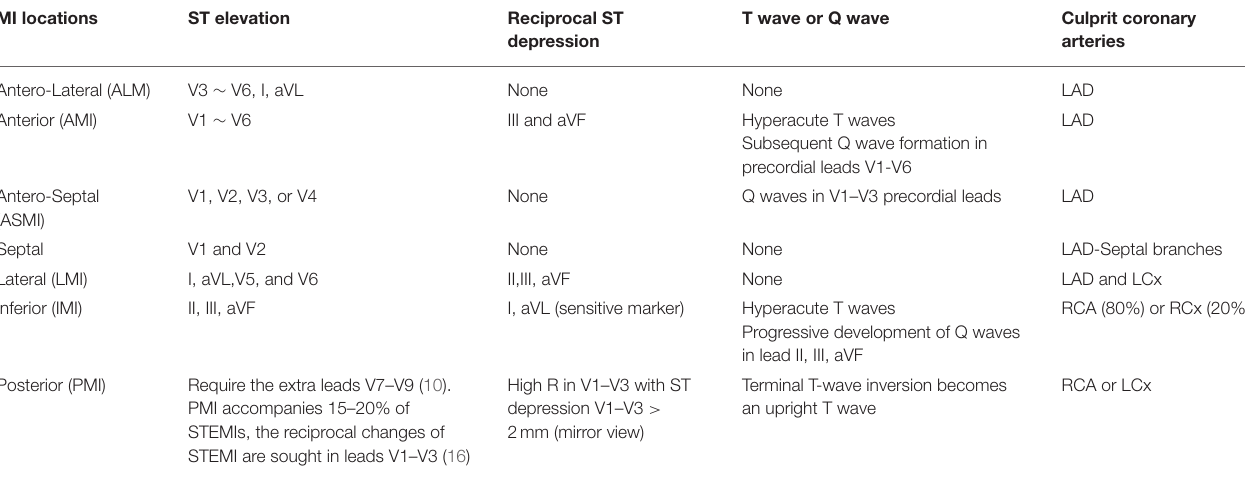
TABLE 1 | Different myocardial infarction (MI) localizations and corresponding leads and culprit coronary arteries. MI locations